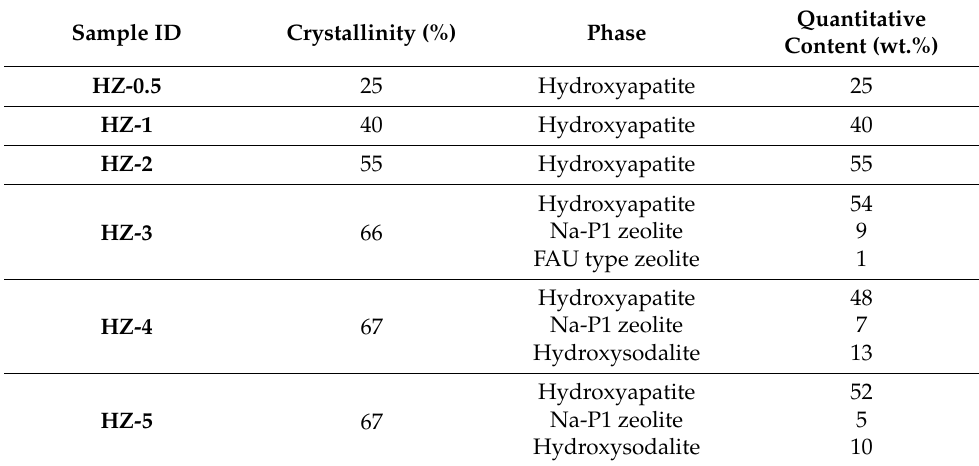
Table 2. Crystallinities and quantitative contents of the phases of the synthesized composite samples measured from XRD patterns using the reference intensity ratio (RIR)